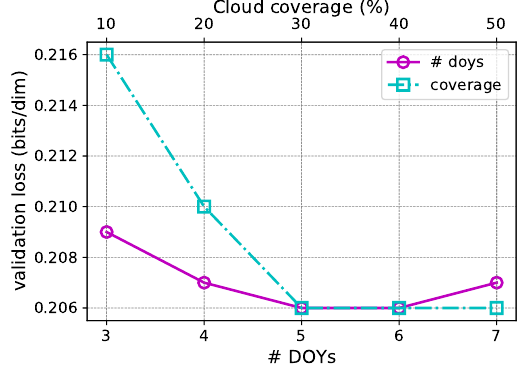
Figure 2. Validation loss in relation to number of DOYs provided as input and maximum cloud coverage considered during training.